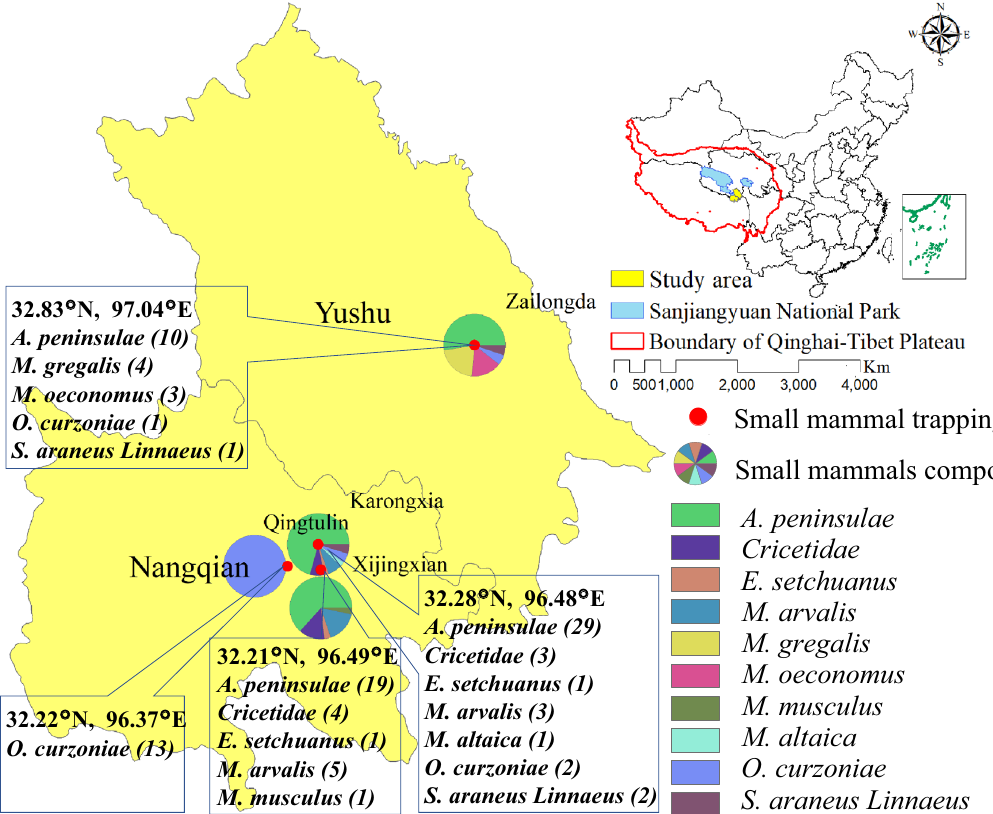
Figure 1. Geographical distribution of the trapped small mammals in the central region of the Qinghai-Tibetan Plateau, China. The map was prepared in ArcGIS 10.2.2 using political boundaries from the National Geomatics Center of China (http:// www. ngcc. cn/ ngcc) for illustrative purposes only, these data are available free of